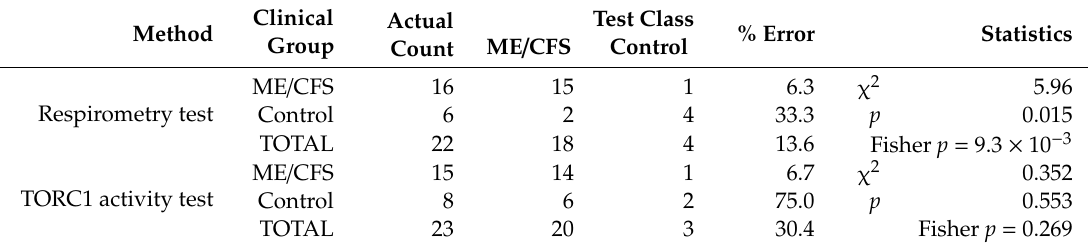
Table 6. “Confusion matrix” analysis of respirometry and TORC1 activity tests for participants whose lymphocytes had not been tested for the rate of cell death in